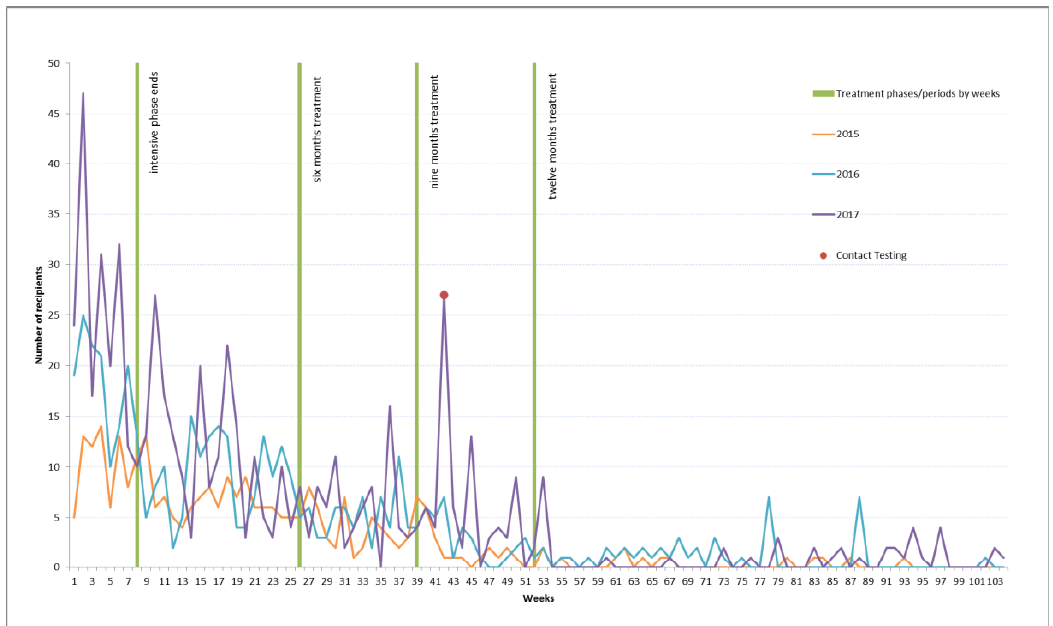
Figure 1. Days between Notification and Receipt of First Voucher by Year, 2015–2017.